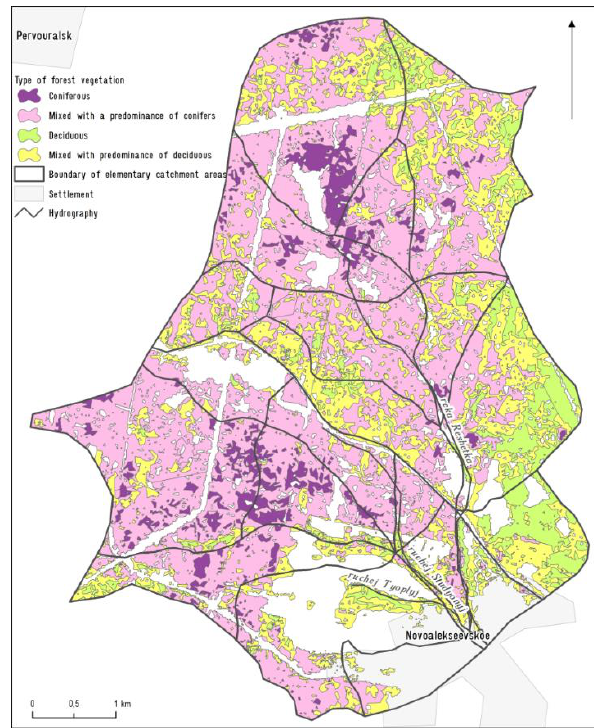
Figure 5. Types of vegetation in the model watershed of the Reshetka river up to a section line in the village of Novoalekseevskoe.